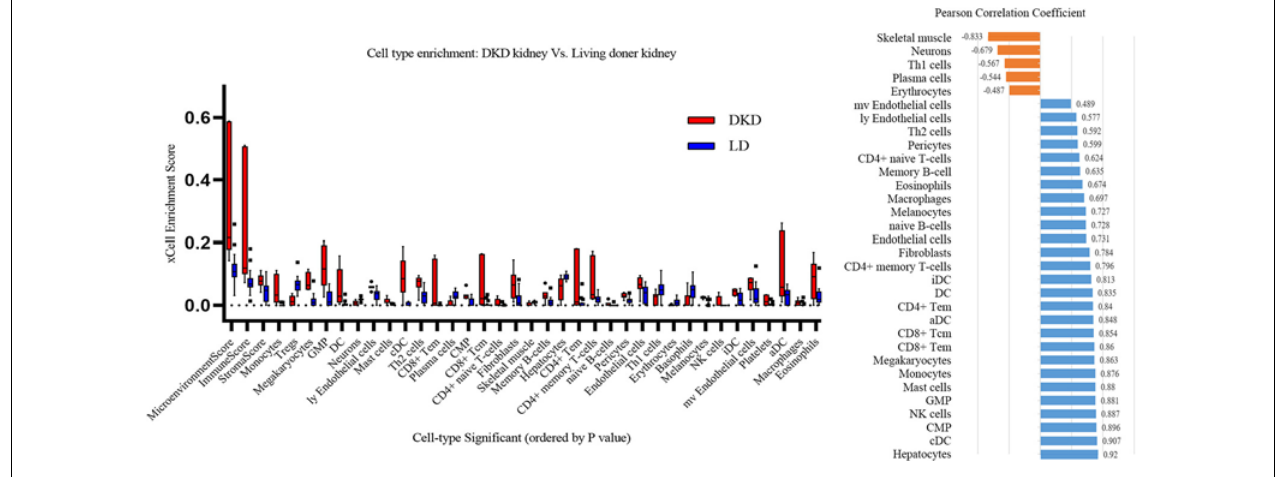
FIGURE 6 | Immune cells enrichment. (A) Contrast of cell-type enrichment score between DKD and LD with P < 0.05. (B) Correlation of versican levels and expression levels ranking of cells in Figure 6A , except for basophils, platelets, and Treg cells which were not correlated with versican expression ( P >